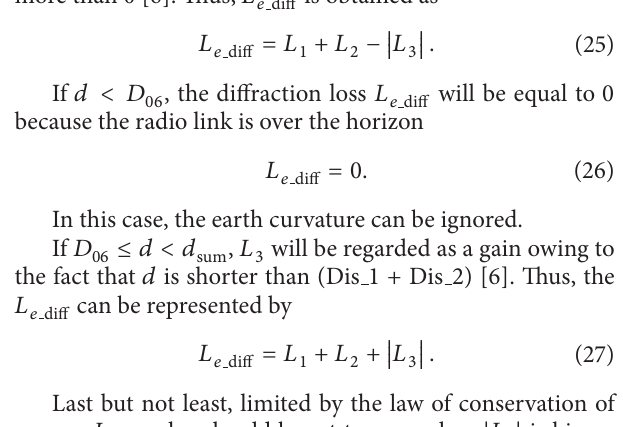
Figure 21: Divergence coefficient as a function of the TX-RX = 79.55 m, ℎ = 3.4 m). distance ( ℎ TX RX